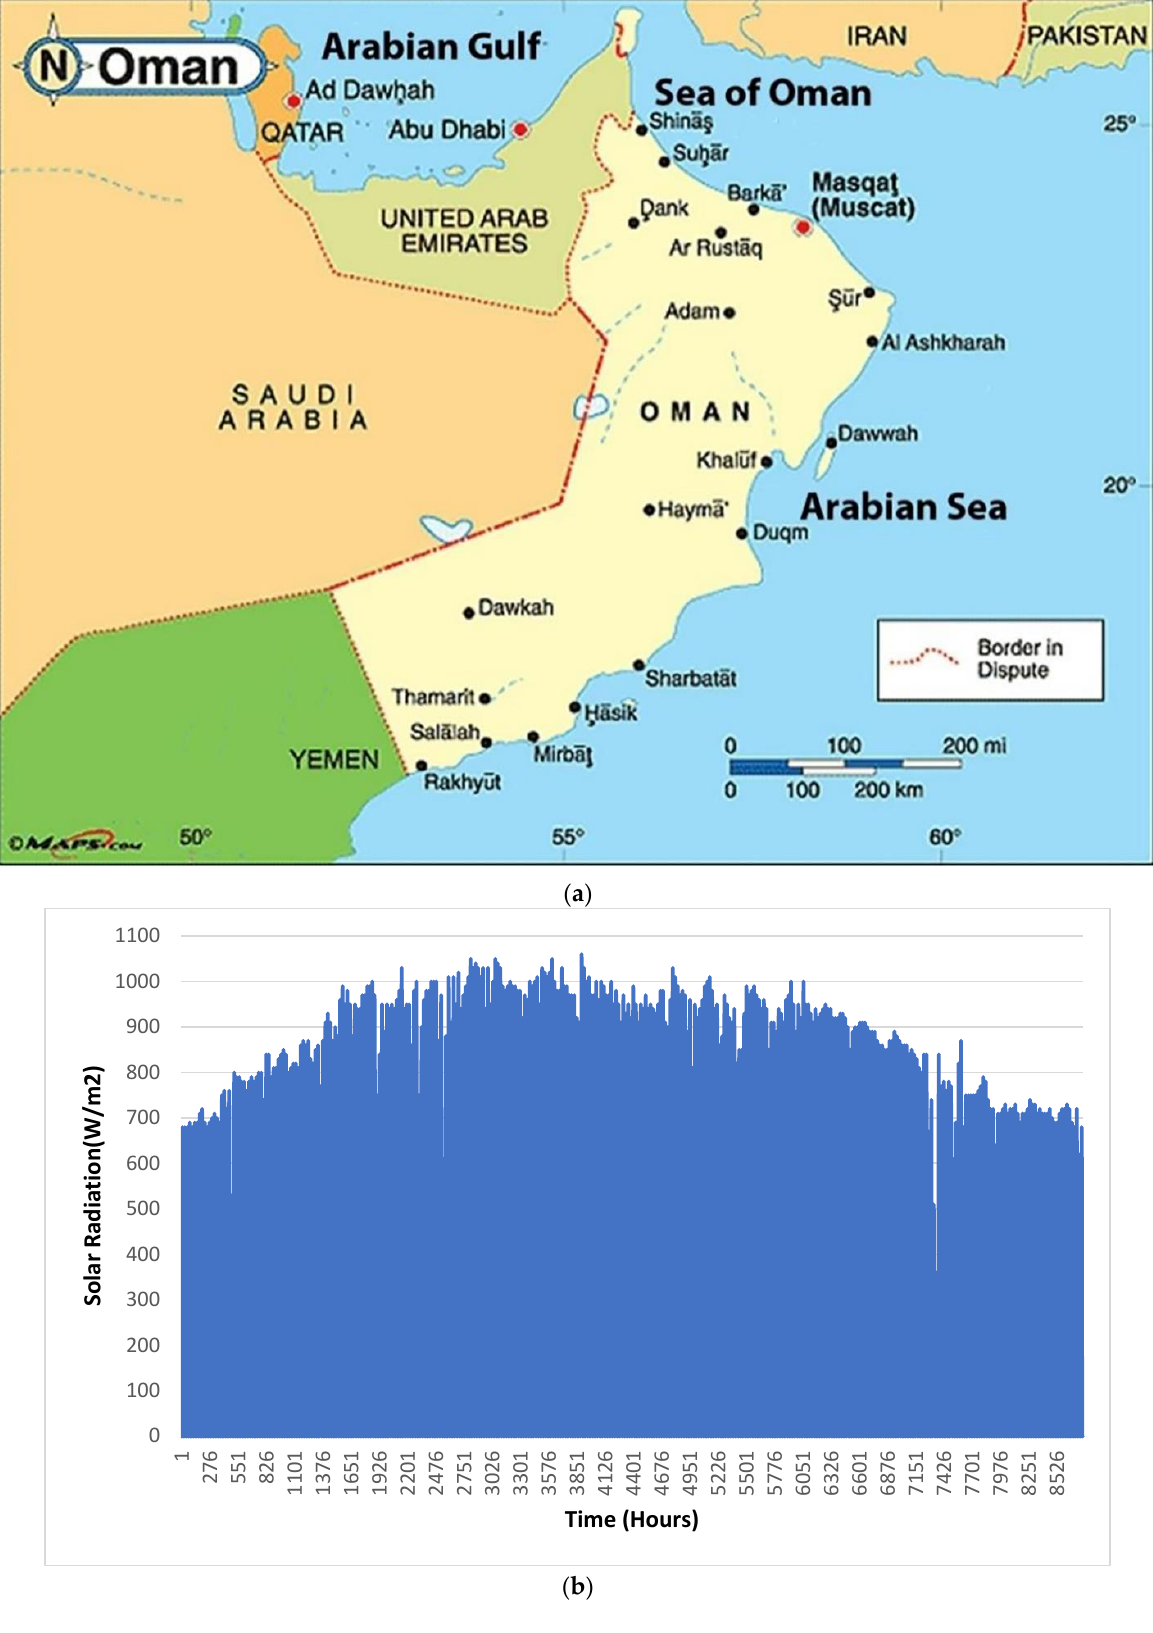
Figure 4. ( a ) Map of Oman (Source: https://www.cbd.int/doc/world/om/om-nr-05-en.pdf, 25 April 2022); ( b ) Mean hourly solar radiation for Sohar city collected by the author.